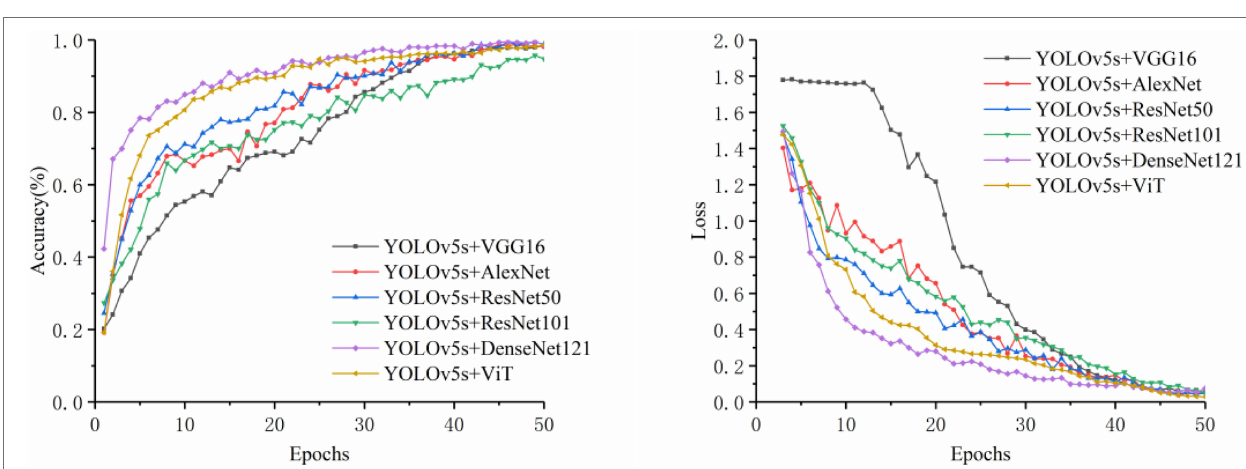
FIGURE 5 | Comparison of accuracy and loss for detection plus classification.